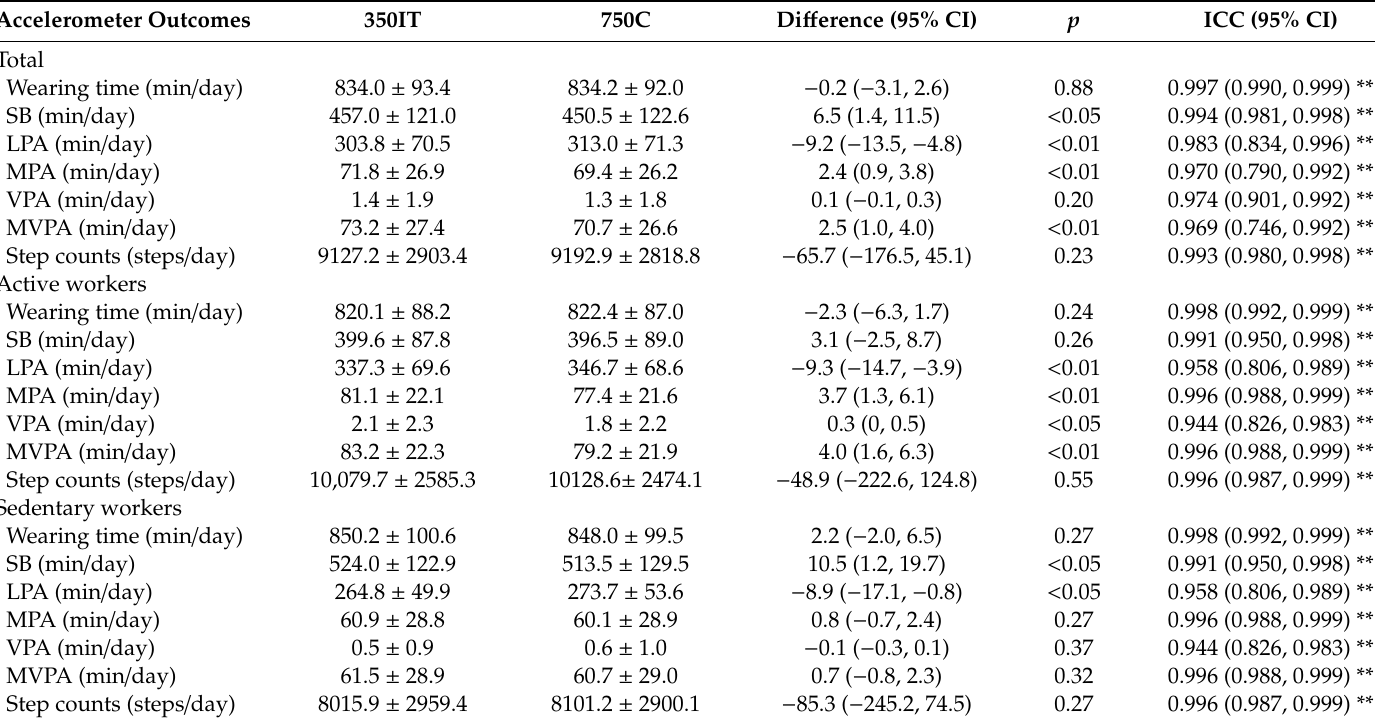
Table 2. Mean of accelerometer outcomes between 750C and 350IT